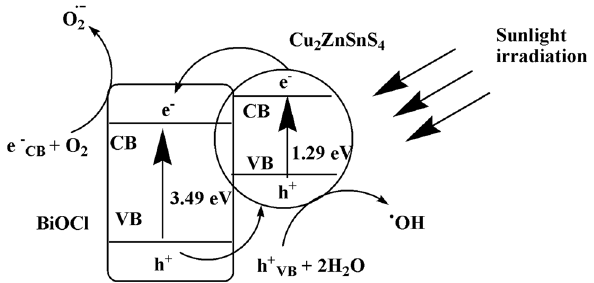
2 ZnSnS 4 hetero-